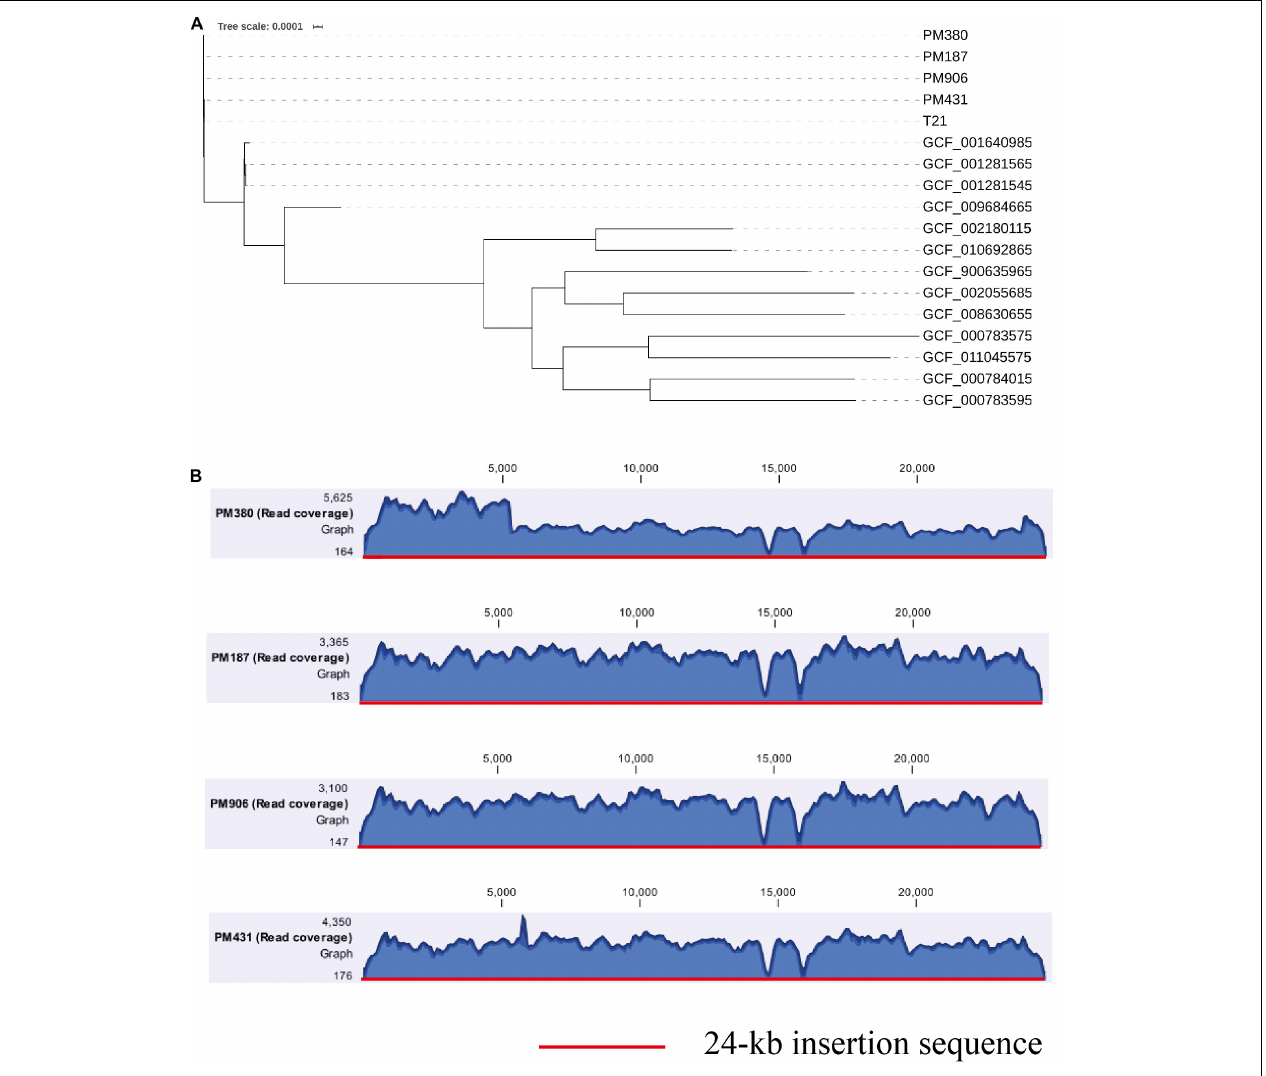
FIGURE 3 | (A) A maximum-likelihood phylogenetic analysis of P. mirabilis strains. (B) Coverage of Illumina reads for four P. mirabilis strains (PM380, PM187, PM906, and PM431) mapped to the 24-kb insertion shown in Figure 2 . The mean coverage for each strain is denoted by a curve